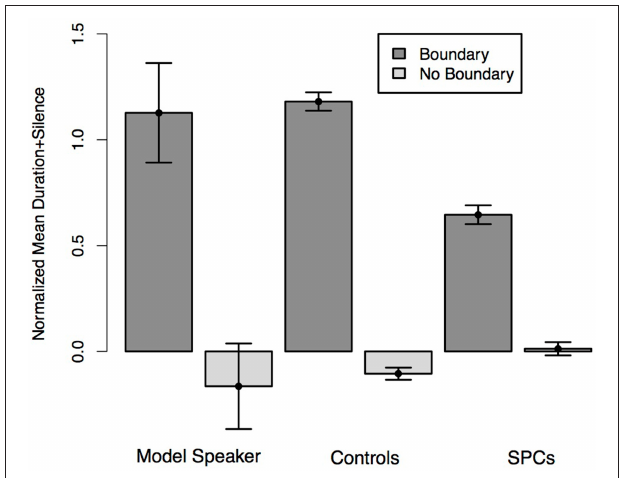
FIGURE 5 | Normalized average duration plus silence of the second conjunct of the Ambiguous Coordinate Structure sentences depending on whether the speaker intended the two-one (Boundary) or two-two (No Boundary) structure as produced by the Model Speaker, Controls, and SPCs. Error bars represent standard errors.